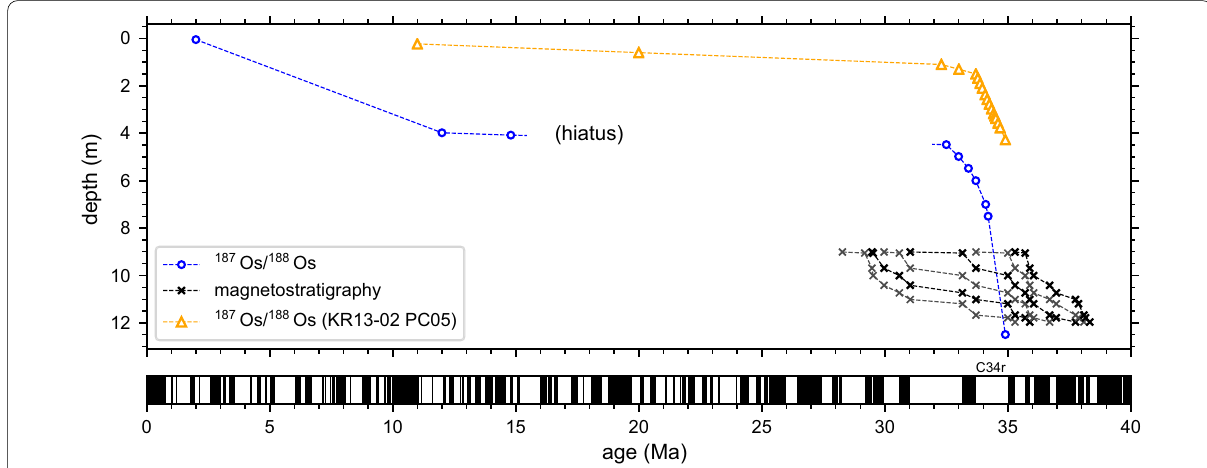
Fig. 4 Age–depth plot based on 187 Os/ 188 Os (blue circles; Nozaki et al. 2019) and paleomagnetism (gray crosses; Additional file 3: Table 1). Also shown is the 187 Os/ 188 Os ages of KR13-02 PC05 (orange triangles; Ohta et al. 2020). Shown at the bottom is the geomagnetic polarity time scale (Ogg 2012). Black represents normal polarity, white represents reversed